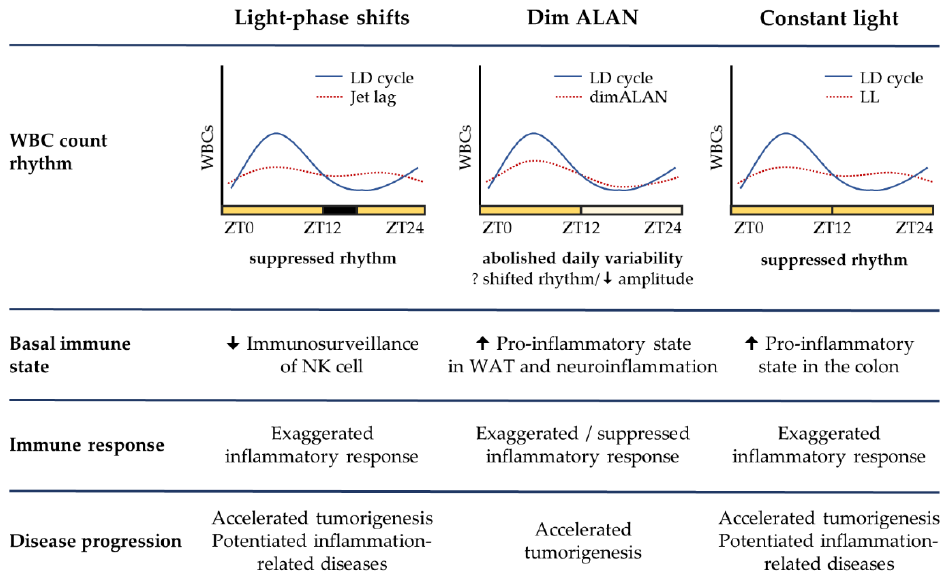
Figure 1. Comparison of three disruptive light/dark regimes and their effects on the immune measures based on the current knowledge in laboratory animals. ALAN—artificial light at night; LD—standard light/dark cycle of 12/12 h; LL—constant light; WAT—white adipose tissue; WBCs—white blood cells; ZT—Zeitgeber time.